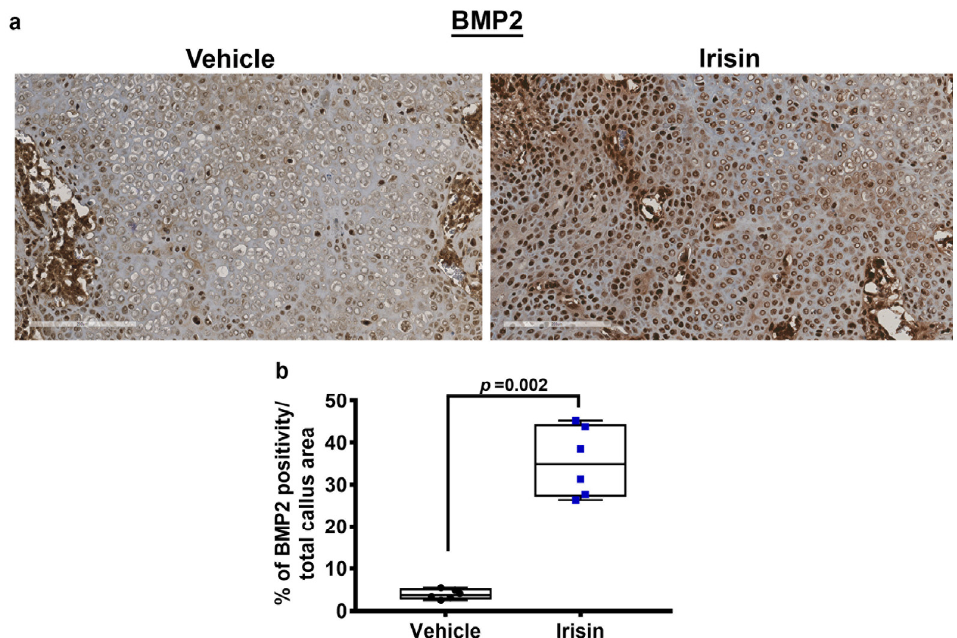
Figure 4. Representative images of ( a ) BMP2 immunostaining on callus section from vehicle-treated mice ( n = 6) and irisin-treated mice ( n = 6) 10 days after fracture (scale bars 200 µm). Quantification of ( b ) BMP2 expression is shown as dot plots. Data are presented as dot plots with median, from max to min, and all data points are shown. Mann–Whitney test was used to compare groups.